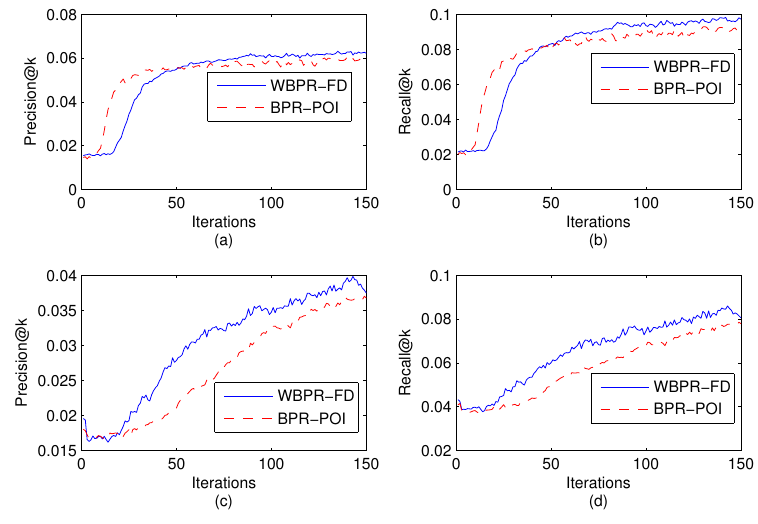
Figure 10. Convergence analysis on the Gowalla and Brightkite datasets. ( a ) Precision @ k in Gowalla; ( b ) Recall @ k in Gowalla; ( c ) Precision @ k in Brightkite; ( d ) Recall @ k in